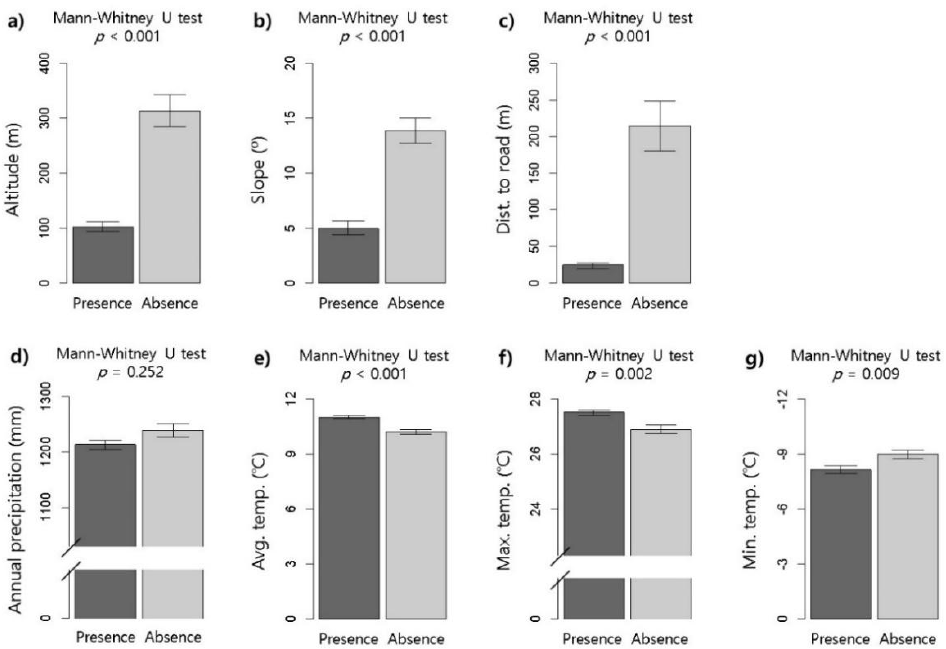
Figure 4. Differences in environmental conditions between the presence and absence sites of Metcalfa pruinosa . Bars denote averages and standard errors. The p -value ( p ) was calculated based on the Mann–Whitney U test. ( a ) Altitude, ( b ) slope, ( c ) distance to road, ( d ) annual precipitation, ( e ) annual average temperature, ( f ) maximum temperature in July, and ( g ) minimum temperature in January.